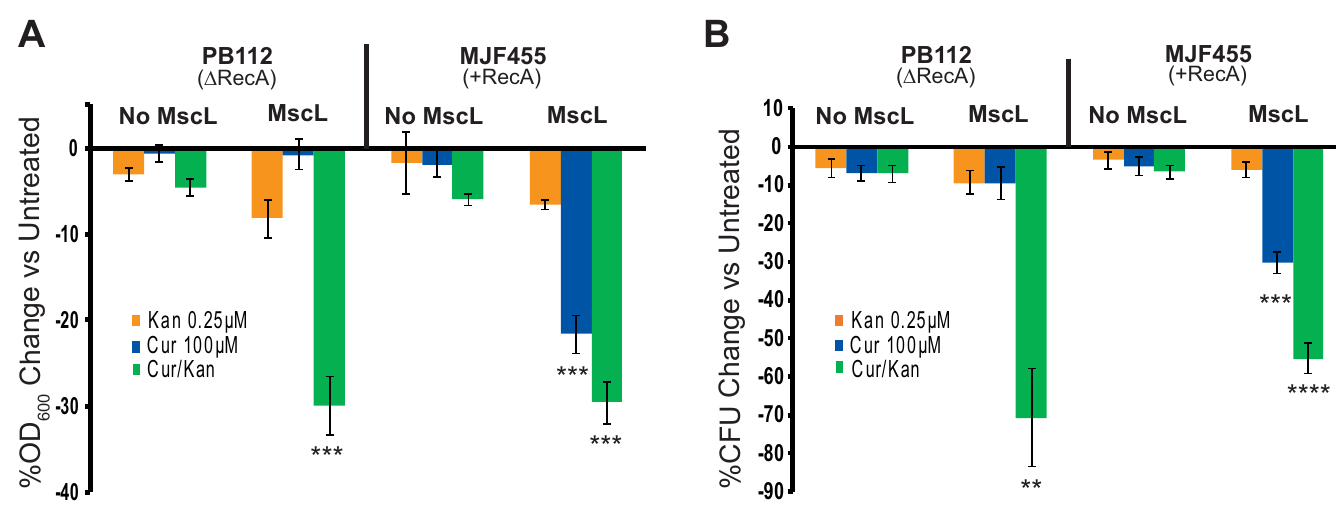
Fig 6. Curcumin antibiotic synergy is MscL-dependent but RecA-independent. Shown are the E . coli Stains PB112 ( Δ recA, Δ MscL, Δ MscS) and MJF455 ( Δ MscL, Δ MscS) carrying vector only (No MscL) or expressing MscL (MscL), treated with 0.25 μ M kanamycin (yellow), 100 μ M curcumin (blue), or a combination of the two (green). A) Inhibition of growth (OD 600 ) treated as indicated, expressed as the percentage change of the untreated. n = 4, Statistics reflect a comparison of MscL- expressing versus “no MscL” strains ��� P < 0.0005 as indicated, 2-tailed t-test.